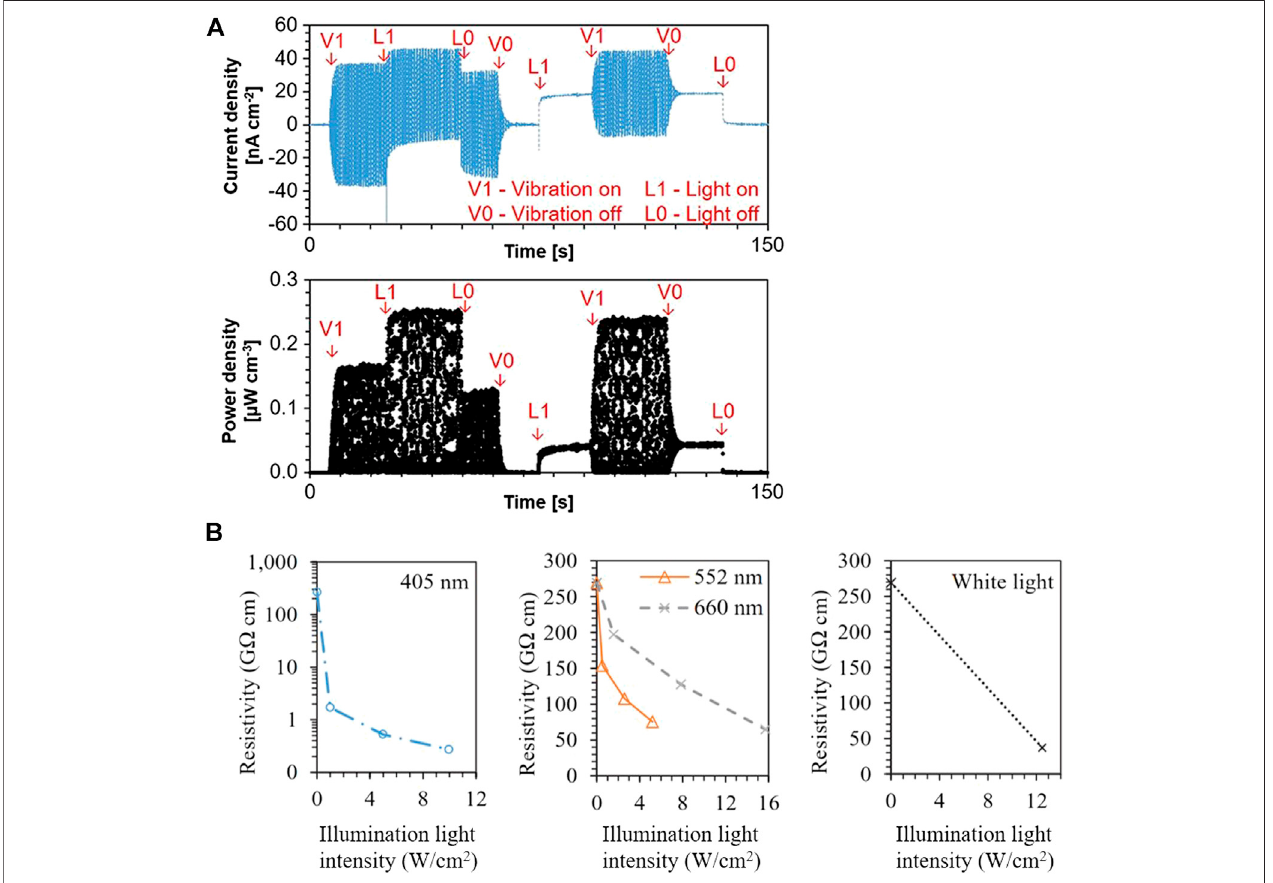
FIGURE3|(A) Outputcurrentandpowerdensitiesofasingle-material,dual-sourcesensorusingKNBNNO fromthepiezoelectricandphotovoltaiceffectsexcited by vibration and light, respectively. (B) Dependence of resistivity on light wavelength and intensity for a KNBNNO ceramic sample. Reproduced with permissions